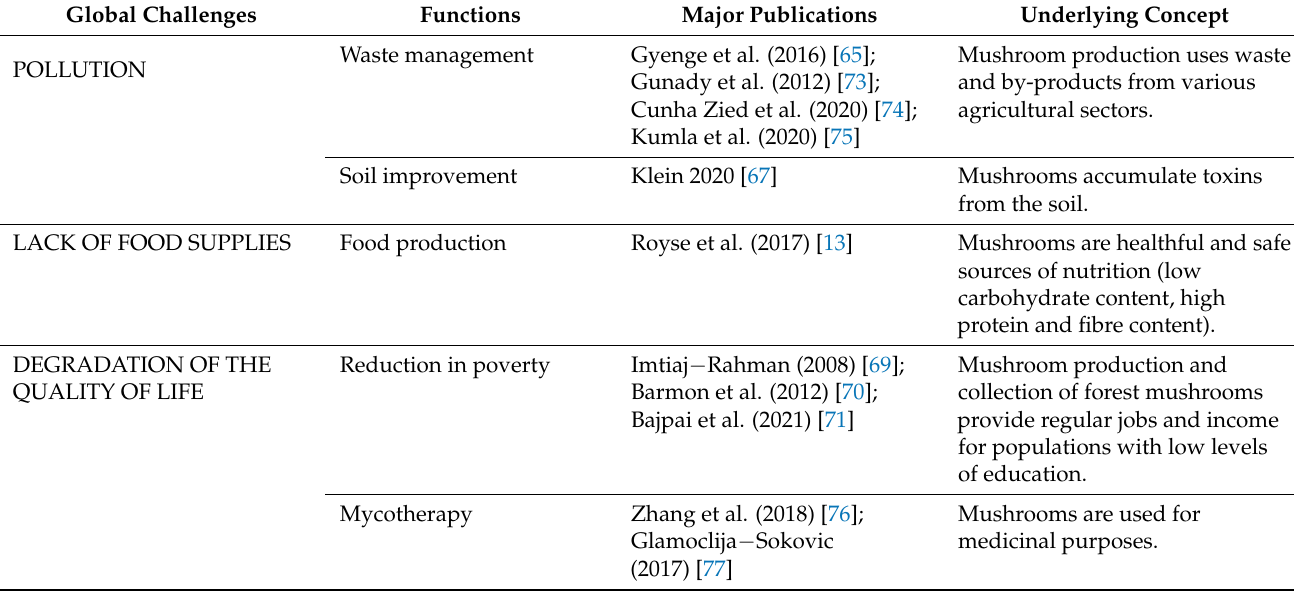
Table 2. A summary of related literature: The significance of mushroom production and consumption in solving global problems. Global